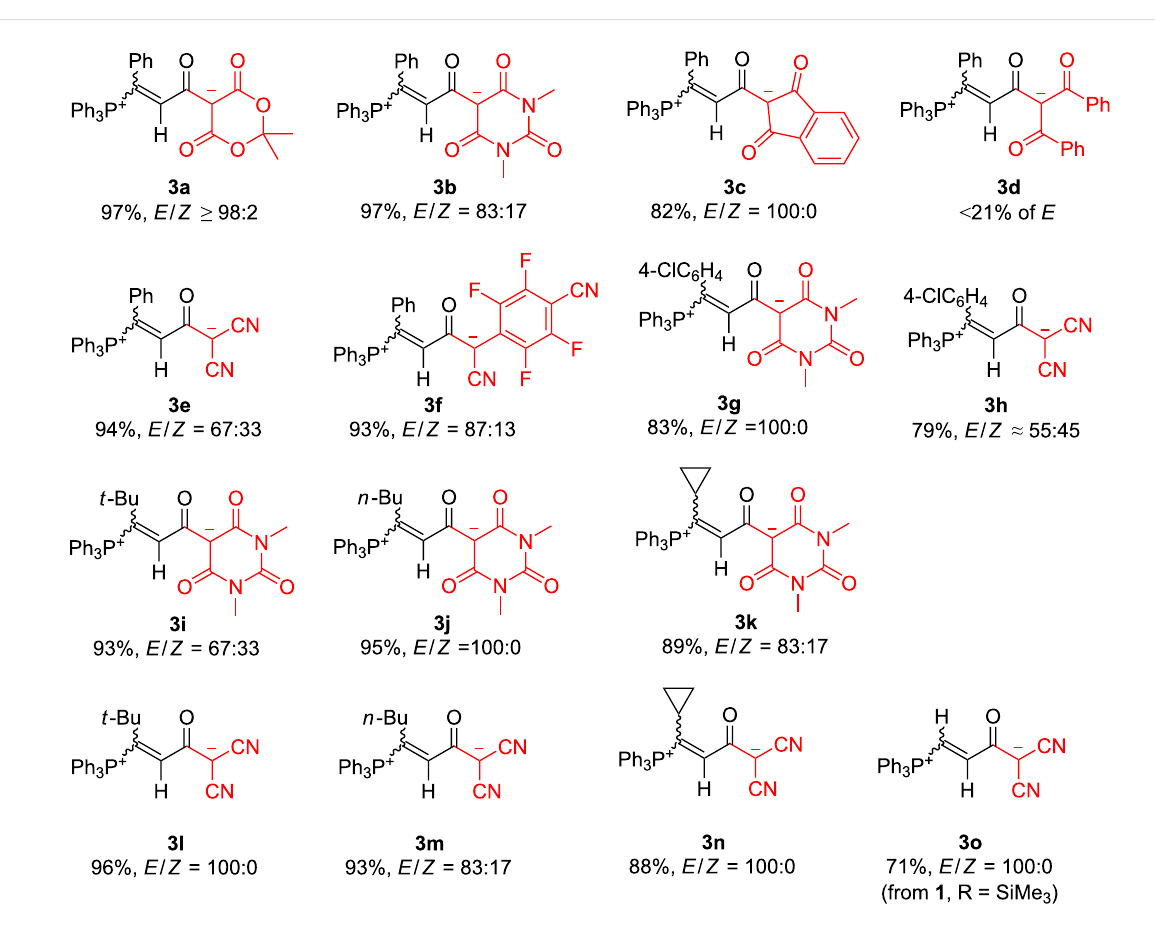
Figure 1: Phosphonium betaines 3 prepared. An E : Z ratio of 100:0 means that only the E -isomer was observed in the NMR